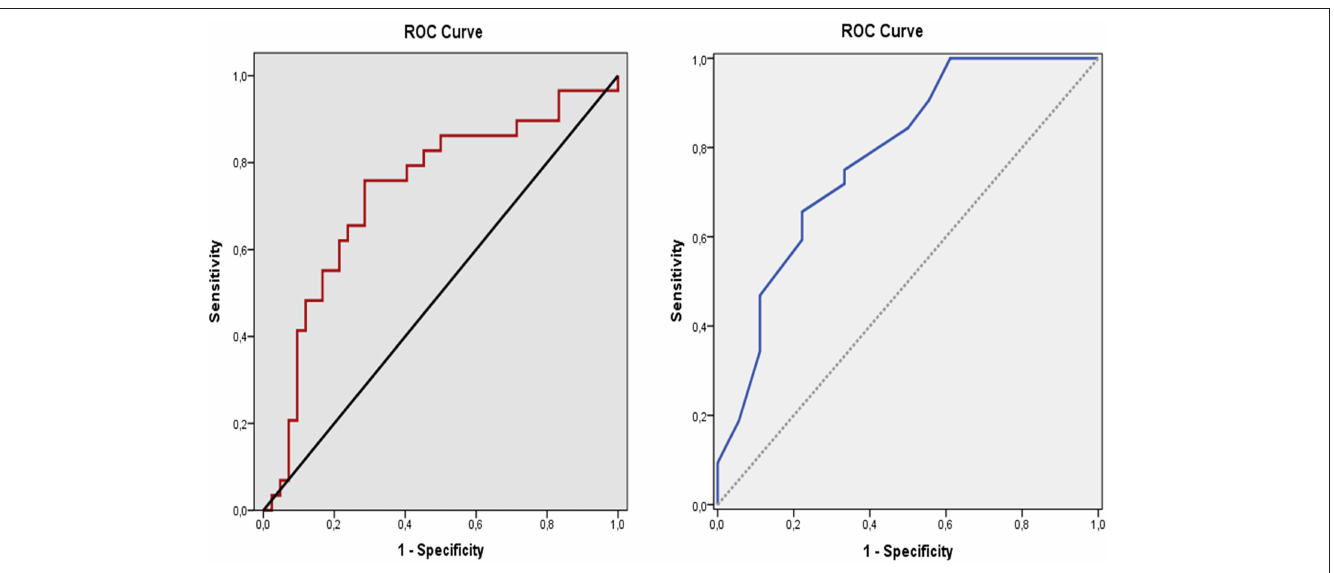
: (A) ROC curves of SII (AUC = 0.732; 95% CI = 0.609-0.856; P < .001) for in-hospital mortality. Figure 2. Analysis showing the predictive cut-off value of SII and SpO 2 (B) ROC curves of SpO (AUC = 0.781; 95% CI = 0.943-0.919; P < .001) for in-hospital mortality. AUC, area under the curve; ROC, receiever operator characteristics; 2 SII, systemic immune-inflammation index; SpO , oxygen 2